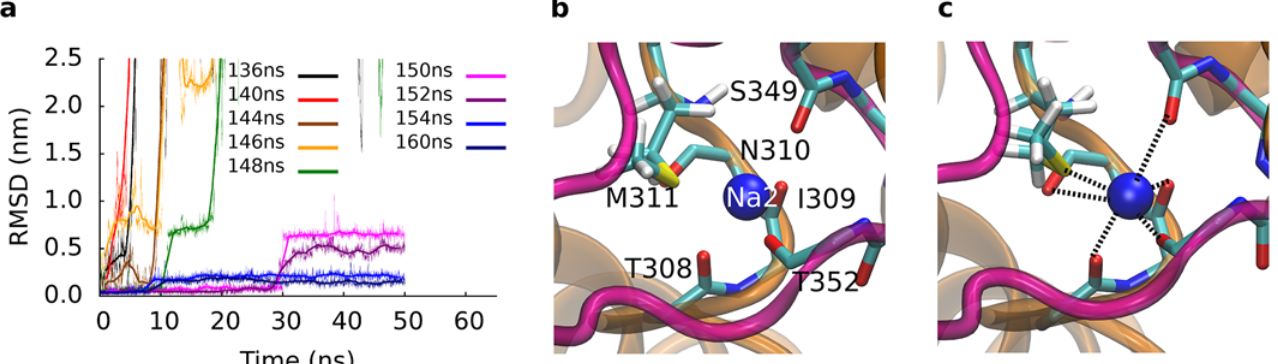
Fig 4. Stabilizing sodium to the Na2 site. We extracted closely spaces snapshots before and after the rotation of T308 and carried out 50 ns long simulations. (a) The RMSD of sodium 2 reflects the stability of the reinserted sodium. The time evolution of the RMSD can be classified into two groups: Large RMSD and unbinding before T308 rotation, and sodium bound to the Na2 site after rotation of T308. Panel (b) and (c) show the initial and final structure of the simulation initiated for the snapshot extracted at 160 ns. Sodium 2 was reinserted into the Na2 site and remained stable, coordinated by backbone carbonyl oxygens and the sulfur atom of the M311 side chain.